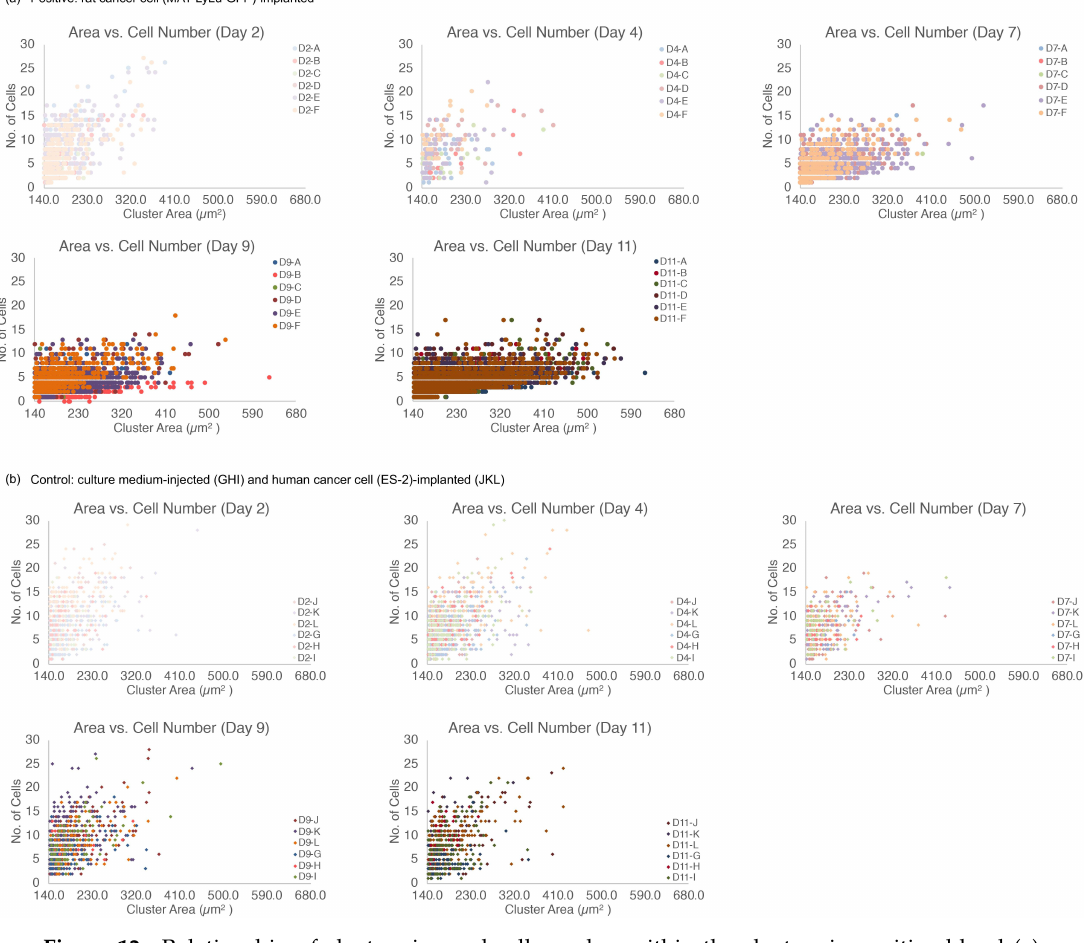
Figure 12. Relationship of cluster size and cell number within the clusters in positive blood ( a ), and combined results of control 1 and control 2 blood ( b ). Each graph shows the results 2, 4, 7, 9, or 11 days after the implantation of rat cancer cells (A–F, positive), culture medium (G–I, Control 1), or human cancer cells (J–L, Control